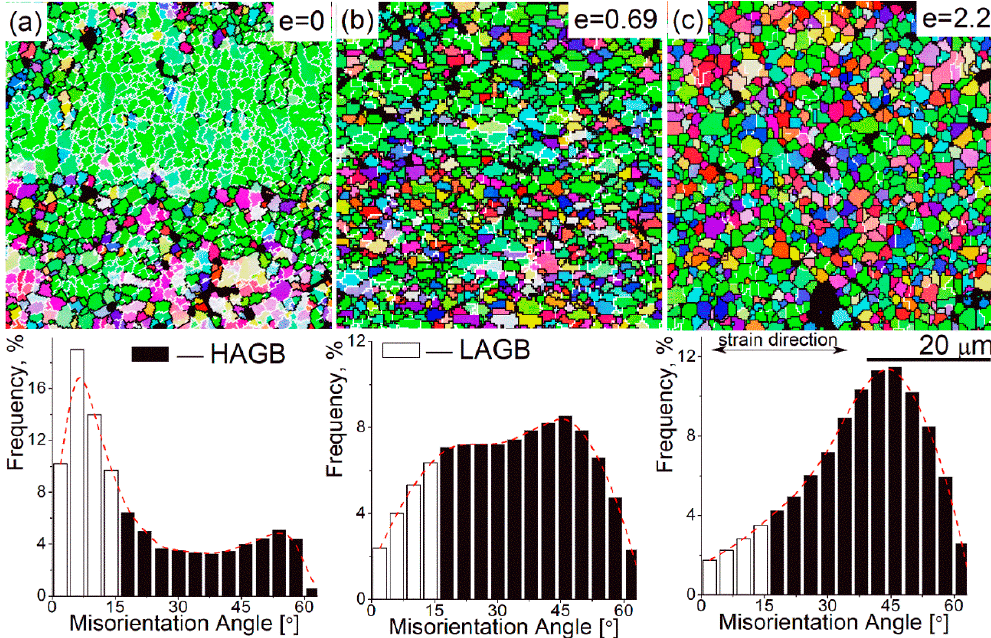
Figure 4. SEM-electron backscatter diffraction (EBSD) grain boundaries maps (the low-angle grain boundaries (LAGBs) are white colored and the high-angle grain boundaries (HAGBs) are black colored in the maps), and the angle misorientation of the samples deformed to 0 ( a ), 0.69 ( b ), 2.2 ( c ) at 0.02 s − 1 and 440 °C.